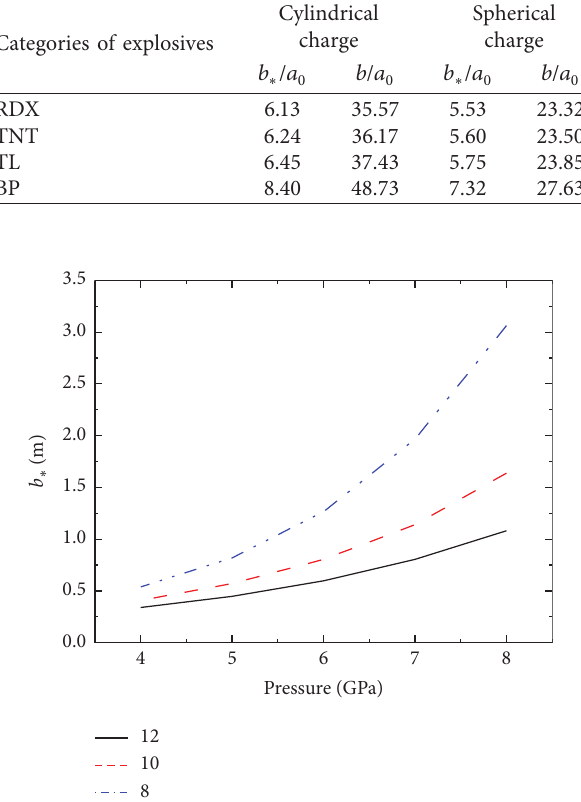
Figure 5: Change curve of the crushed zone under different P ∗ c values of the cylindrical charge.